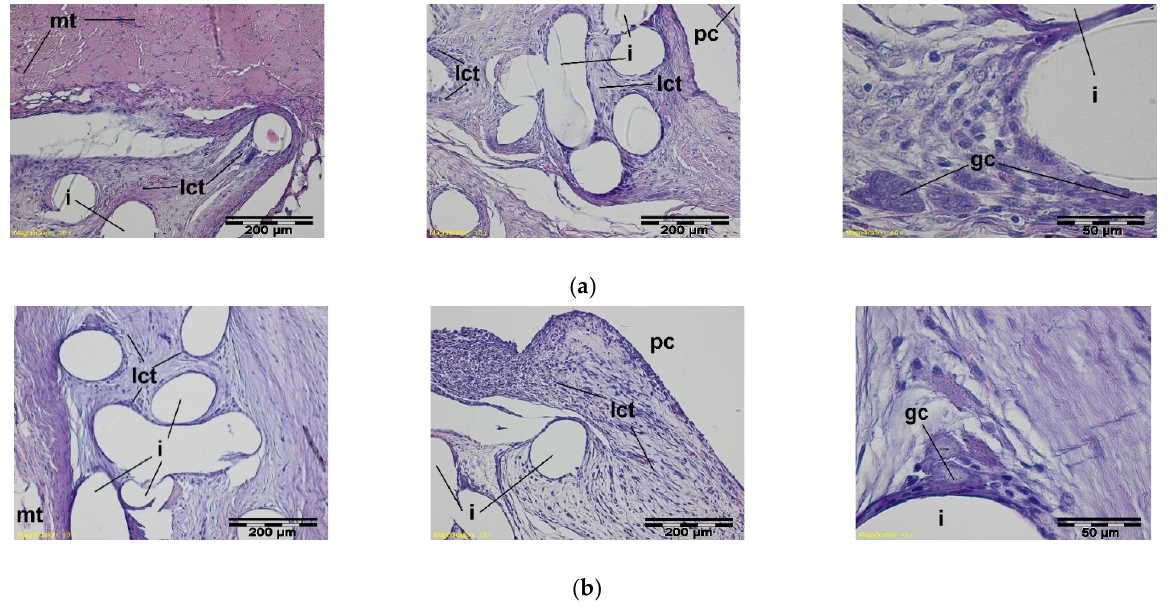
Figure 9. A microscopic view of the PACVD-modified implant ( a ) and reference ( b ) 2 weeks after the implantation in the abdominal wall of a NZW rabbit. Monofilaments of knitted structure (i) are surrounded by loose connective tissue; image from the muscle tissue (mt) side (on the left) and from the peritoneal cavity (pc) (in the middle). In the immediate vicinity of the fibers, polynuclear macrophages (gc) are formed (on the right). Magnification, 100 × and 400 × , Stain. HE.